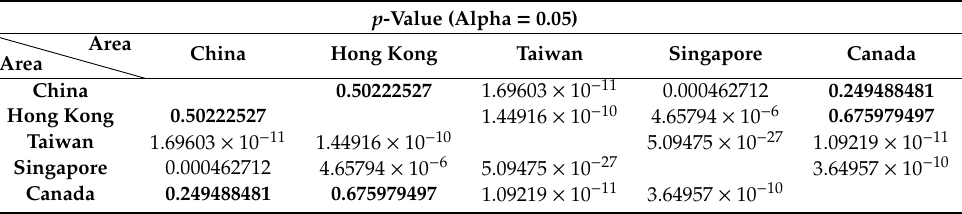
Table 3. p -value of every two areas on to-date cured rate.